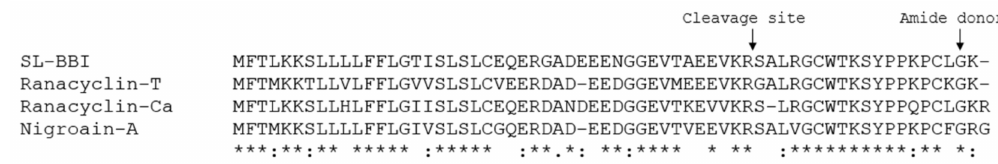
Figure 1. Identification and structural features of SL-BBI. ( a ) Region of RP-HPLC chromatogram of Sylvirana latouchii skin secretion with the elution position of the SL-BBI indicated by a labelled arrow. ( b ) Electrospray ion-trap MS / MS fragmentation data derived from fragment ions corresponding in molecular mass to SL-BBI. Predicted singly and doubly charged b-ions and y-ions are in black typeface. Ions detected by MS / MS fragmentation are indicated in red and blue. ( c ) Nucleotide and translated amino acid sequence of SL-BBI which cloned from the skin secretion-derived library of Sylvirana latouchii . The putative signal sequences are double-underlined, the mature sequences are single-underlined and an asterisk indicates the stop codon. ( d ) Comparison of the structure of HV-BBI and simulated SL-BBI in stick model (CPK colouring, with carbon atoms inside the canonical loop in light blue and outside in grey). The LYS residue at the P1 site was additionally annotated.